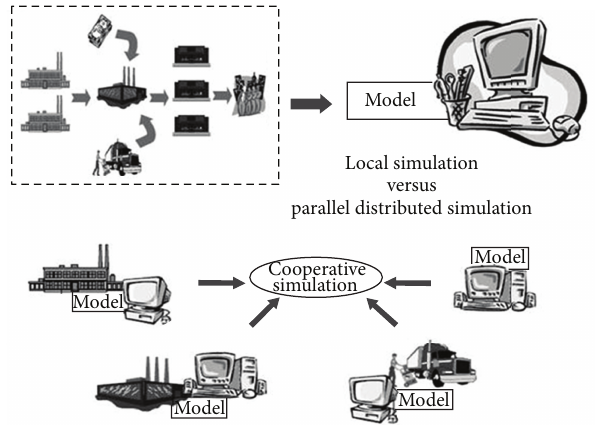
Figure 2: The two paradigms for SCM simulation